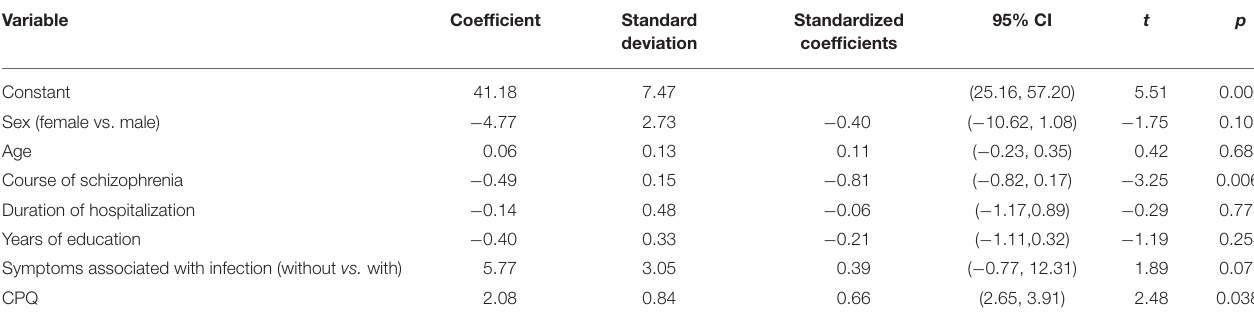
TABLE 2 | Multiple linear regression analysis of influencing factors of patients’ psychological stress. Variable